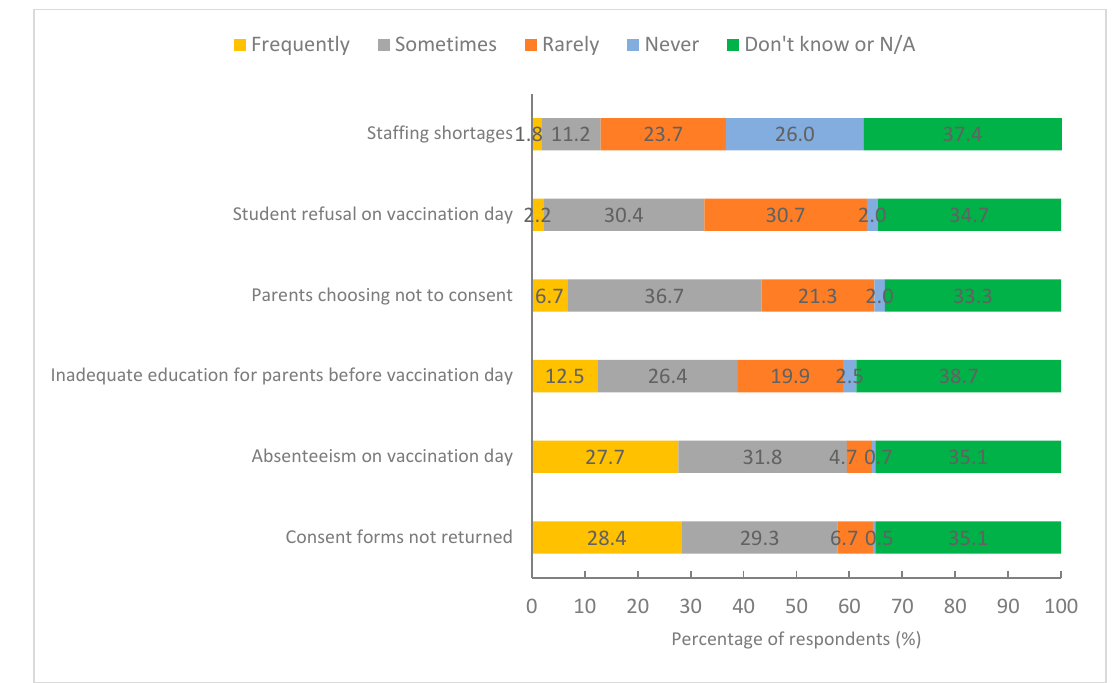
Figure 2. Survey respondent perception of the frequency of factors impacting school ‐ based HPV vaccination coverage ( n = 447).